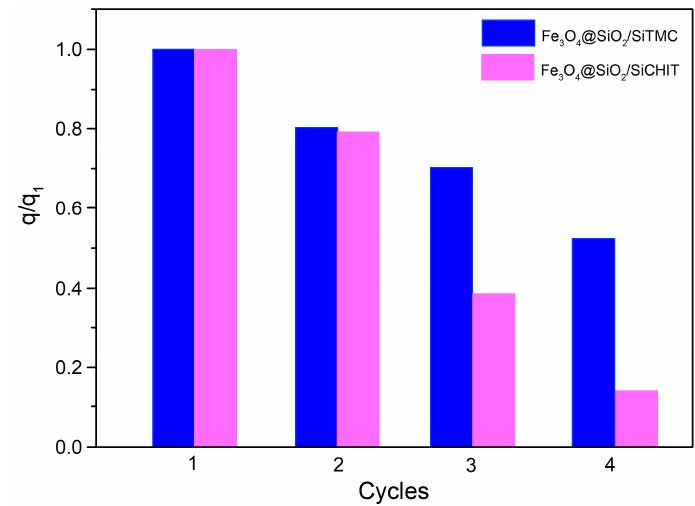
Figure 9. Ratio between the adsorption capacity (q) and the adsorption capacity after first use (q 1 ) for Fe 3 O 4 @SiO 2 /SiTMC and Fe 3 O 4 @SiO 2 /SiCHIT particles in consecutive adsorption/desorption